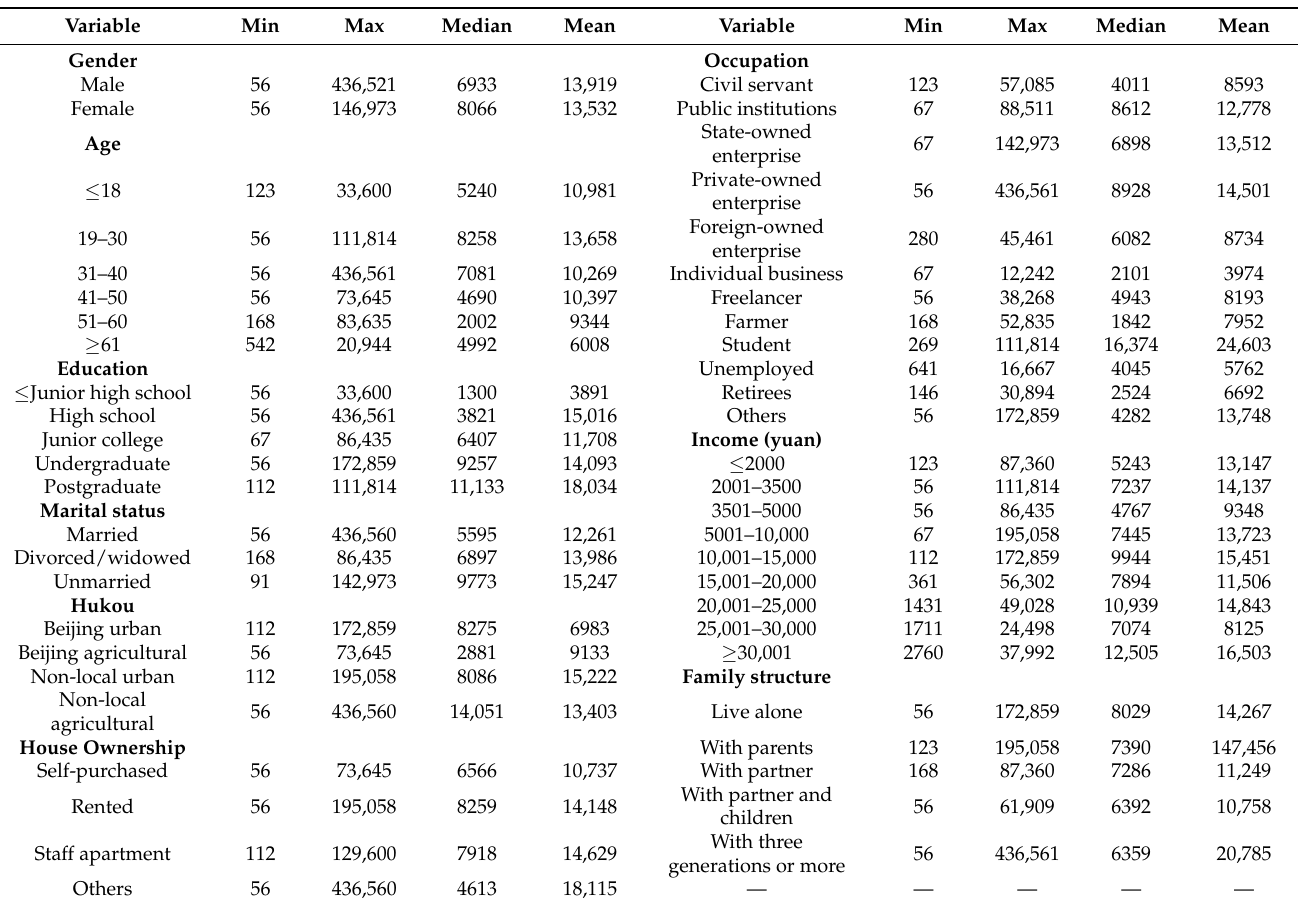
Table A4. Exposure level of different social